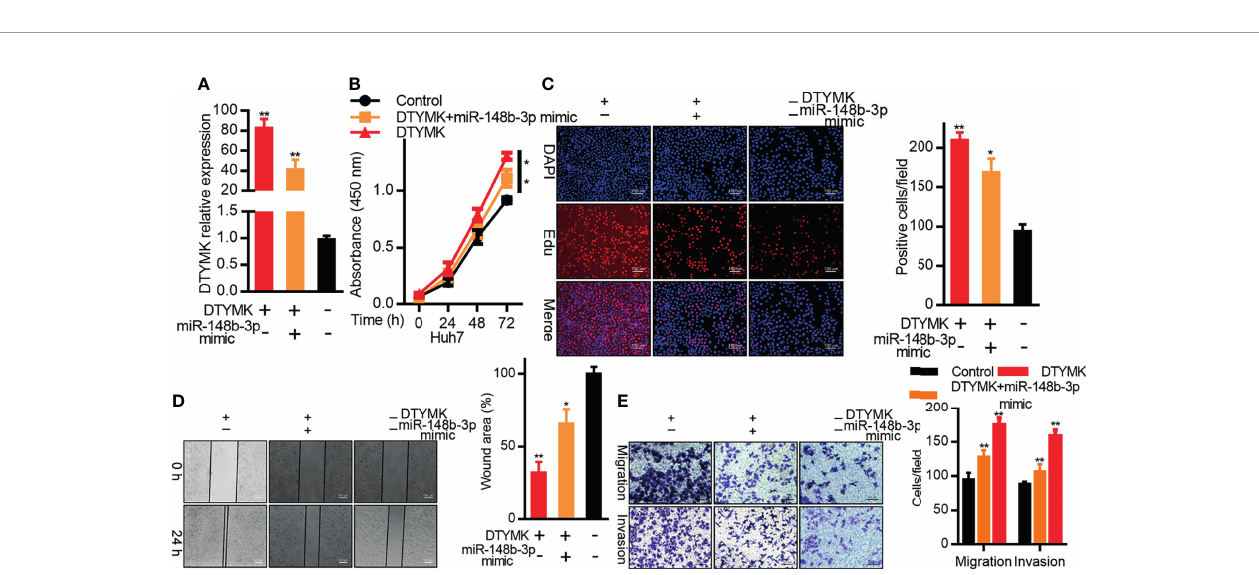
FIGURE 5 | MiR-148b-3p suppresses the pro-tumorigenic activity of DTYMK. (A) DTYMK mRNA expression was assessed in Hep3B cells overexpressing DTYMK and co-transfected with a miR-148b-3p mimic. (B) The proliferation of cells treated as in (A) was assessed via CCK-8 assay and via (C) EdU incorporation staining assay. Scale bar, 100 m m. (D) A wound healing assay was used to assess the migration of cells treated as in (A) . Scale bar, 500 m m. (E) The migratory and invasive activity of cells treated as in (A) was assessed via Transwell assay. Scale bar, 100 m m. Data are means ± SD. * p < 0.05; ** p < 0.01; Student ’ s